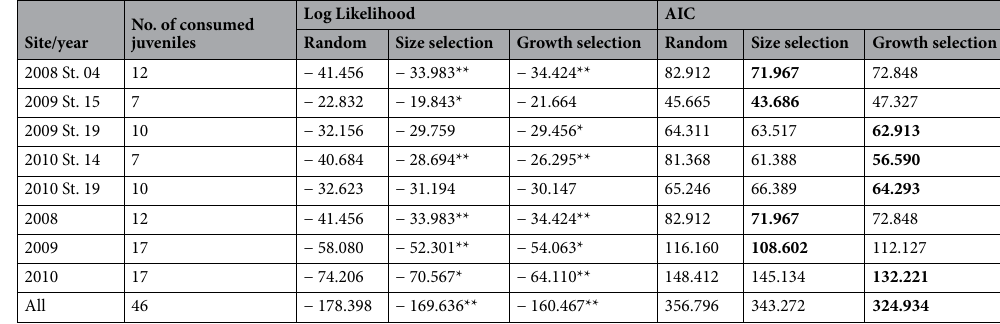
Table 2. Log likelihoods and Akaike’s Information Criteria (AICs) for the models expressing predation selection by Uroteuthis edulis on Trachurus japonicus juveniles in the East China Sea. * and ** indicate p < 0.05 and p < 0.01 in the bootstrap likelihood ratio test against the random predation model. Bold letters in AIC note the minimum AIC among the three